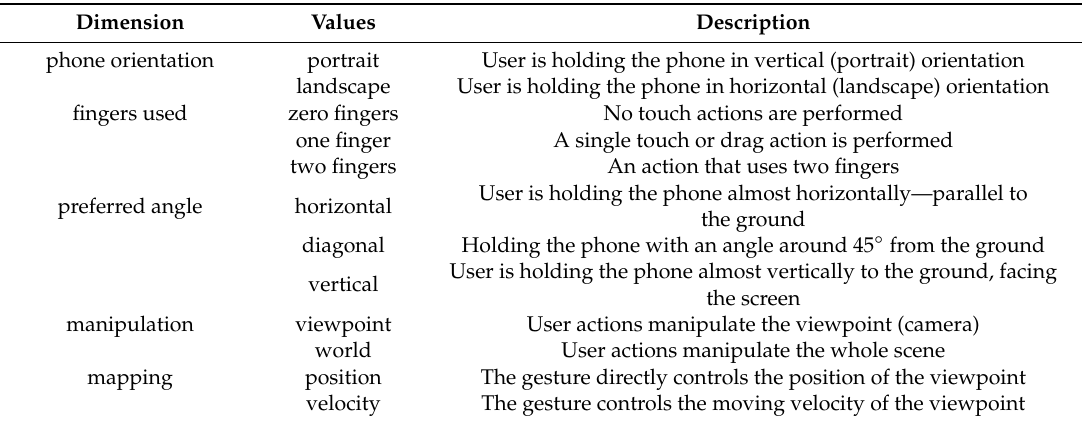
Table 1. The taxonomy used in the